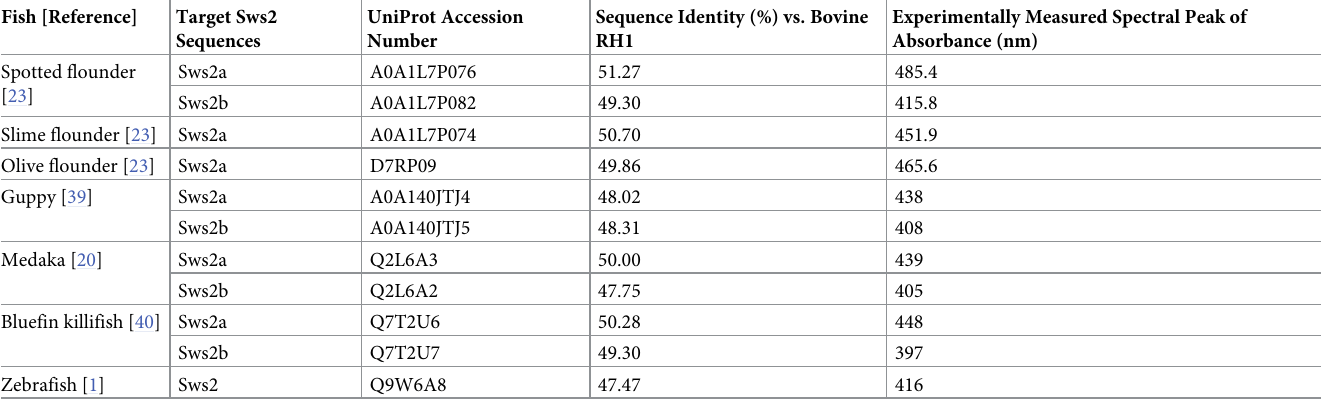
Sequence UniProt accession numbers, percentage sequence identity compared to the bovine RH1 protein sequence, and experimentally measured spectral peaks of absorbance are indicated in third, fourth and fifth columns,